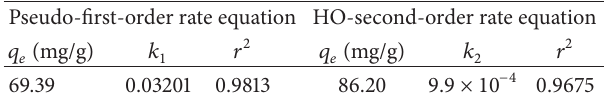
Figure 5: The fitting curve for the controlling step of kinetics. Table 2: The reaction rate constants for Ni 2+ adsorbed on D301R